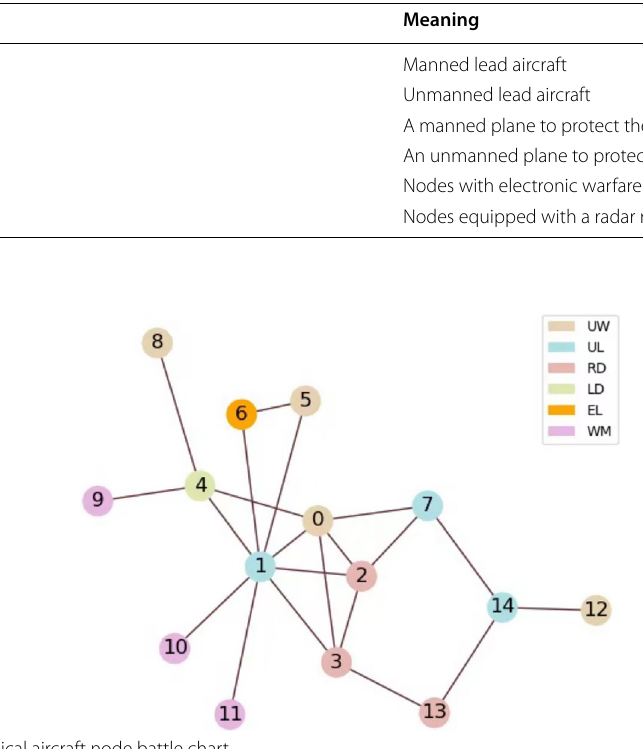
Fig. 1 Typical aircraft node battle